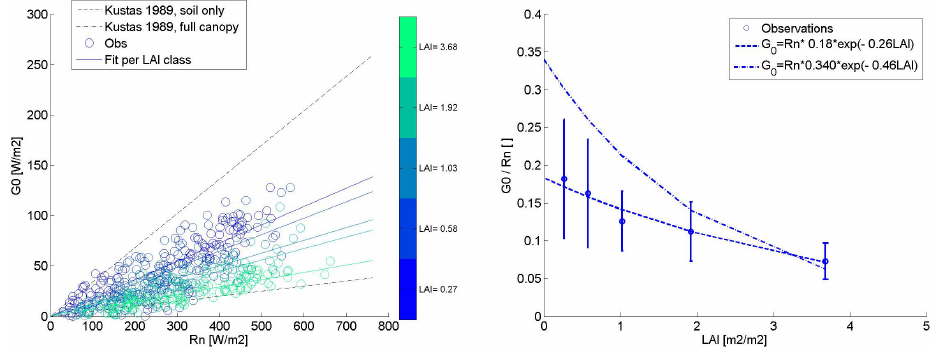
Fig. 4. Comparison between the soil heat flux and the net radiation. In the left panel a scatter plot between the net radiation and the ground heat flux is shown for different LAI classes. In this panel also the theoretical limits by Kustas et al. (1993) are shown. The slopes of the fitted data are shown in the right panel. The error bars denote the standard deviation of the retrieved R n - G 0 ratio. In this panel the parameterization of Kustas et al. (1993) with original values (dash-dotted) and optimized values (dashed) is also